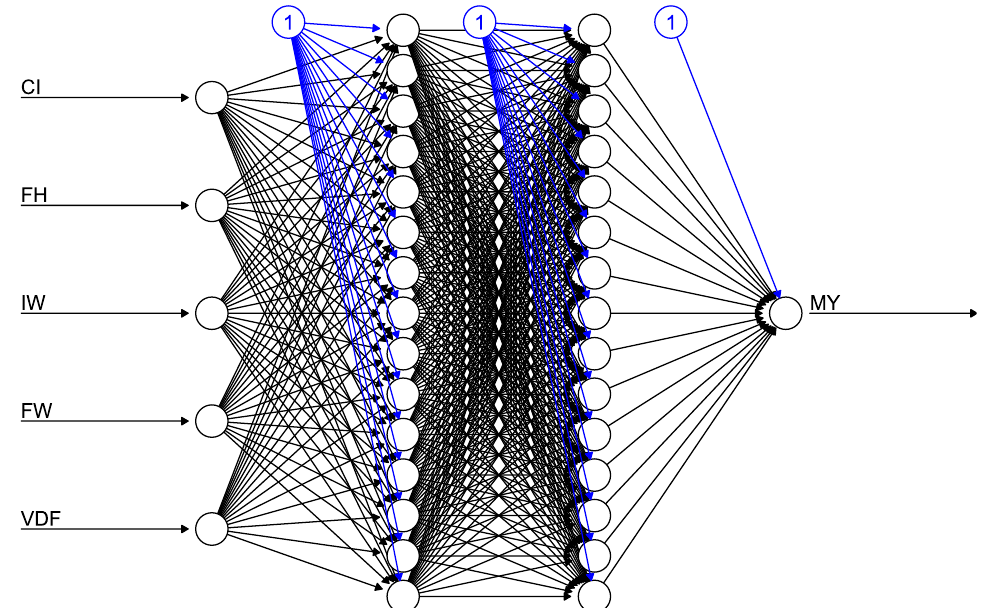
Figure 2. Architecture of used ANN with two-layers and 15 neurons to estimate milk yield (MY) and initial udder circumference (CI), final udder heigh (FH), initial udder width (IW), final udder width (FW), and difference initial and final udder volume (VDF) as input variables.